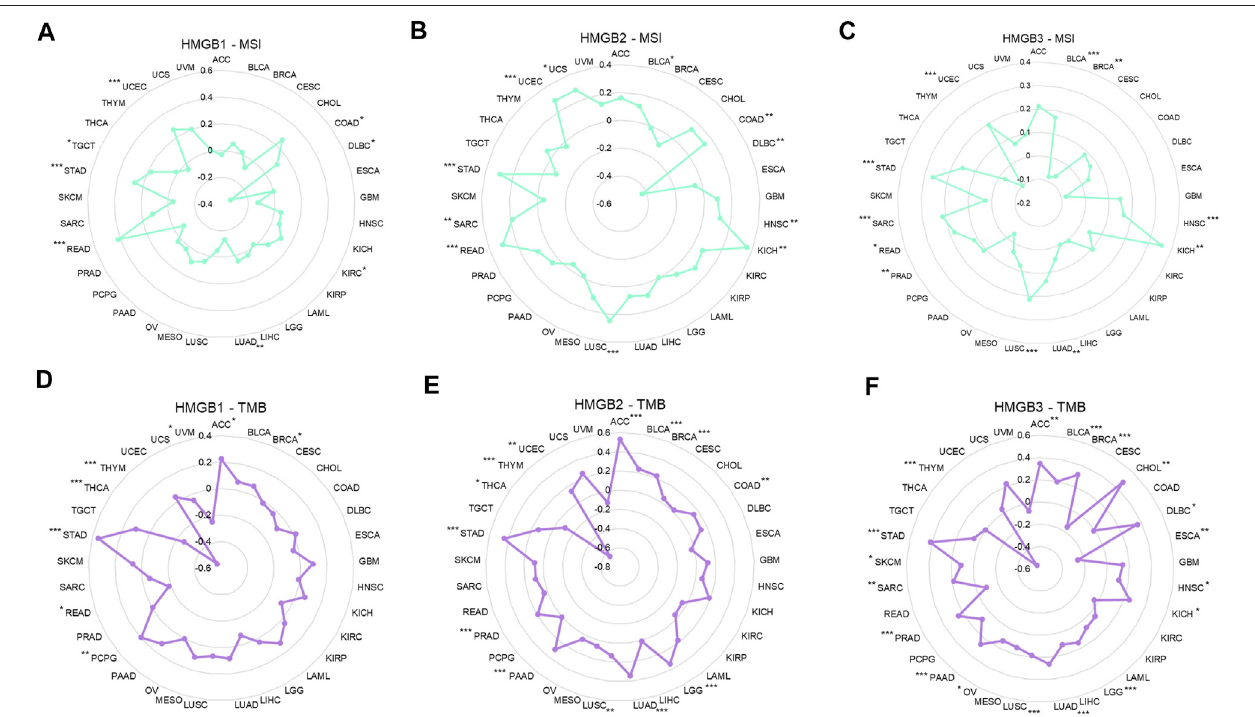
FIGURE6| CorrelationsbetweenHighMobilityGroupBox(HMGBs)expressionandthe (A – C) MSIand (D – F) TMBofcancers.MSI,microsatelliteinstability;TMB, tumor mutational burden.